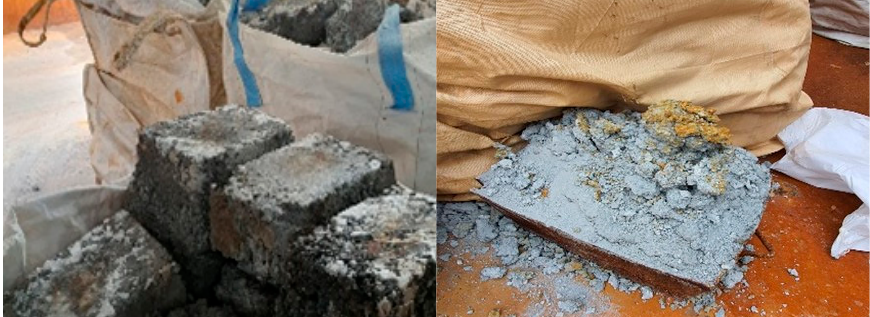
Figure 5. Dross dummy from a melting process of magnesium.